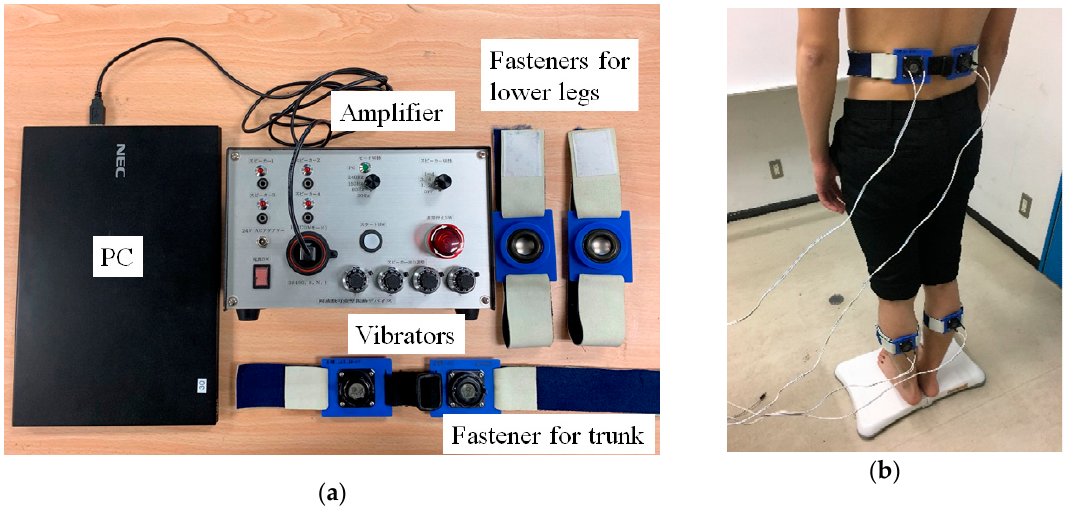
Figure 1. Inspection system for proprioceptive function: ( a ) Variable frequency vibratory stimulation device; and ( b ) experimental setup for a participant.